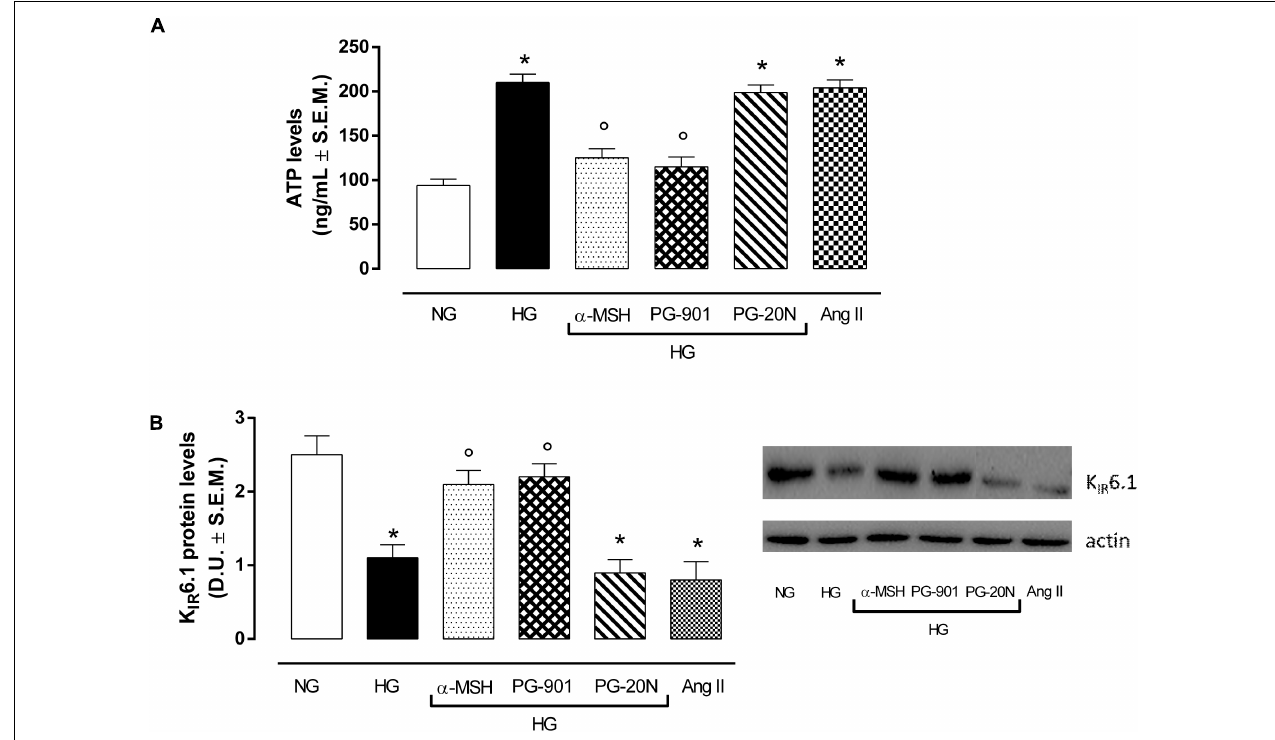
FIGURE 5 | ATP levels as a marker of glucose content andKIR6.1 protein expression. (A) As expected, H9c2 cells exposed to high glucose (33 mM D -glucose) showed increased ATP levels compared to cell exposed to normal glucose (5.5 mM D -glucose). a-MSH (90 pM) and PG-901 (10 − 10 M) significantly decreased ATP levels, reducing the high cellular glucose uptake exhibited by HG cells. PG-20N antagonist did not modify ATP levels. (B) Western Blotting analysis of KIR6.1 protein levels showed a significant KIR6.1 down-regulation in H9c2 cells exposed to high glucose, probably due to high ATP intracellular content. The ATP levels reduction caused by MC5R agonists α -MSH and PG-901in H9c2 cells exposed to high glucose was paralleled by a significant increase in K IR 6.1 protein expression. Values are expressed as mean ± S.E.M. of n = 9 values, obtained from the triplicates of three independent experiments. NG, normal glucose; Ang II, angiotensin II; HG, high glucose; D.U., Densitometric Units; ∗ P < 0,01 vs. NG; ◦ P < 0,01 vs.